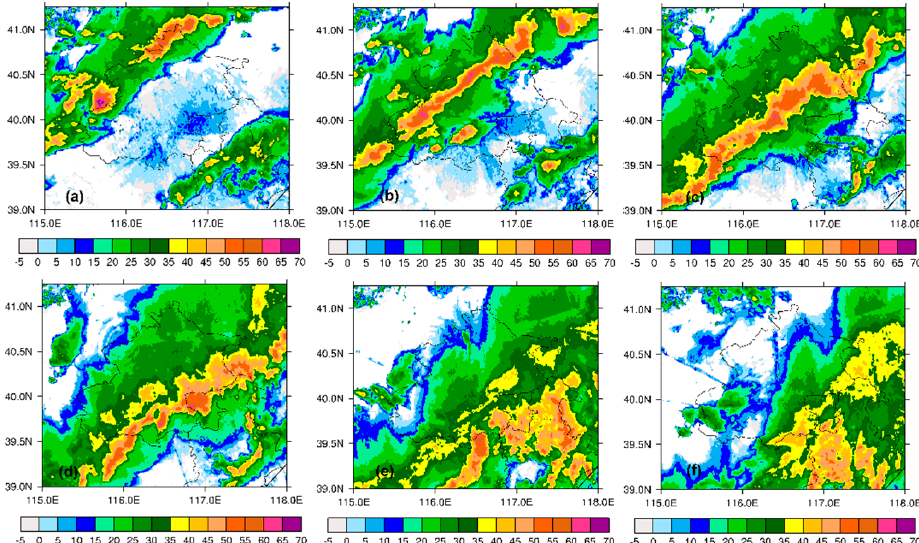
Figure 1. Spatial distribution of hourly composited S-band radar reflectivity factor Z (unit: dBZ) in Beijing on 1 July 2021. ( a – f ) Radar reflectivity factors at 15:00–20:00 BJT.